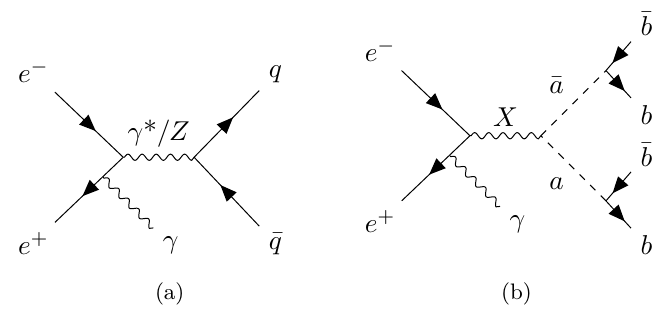
Figure 1. Feynman diagrams of the background (a) and signal (b) processes